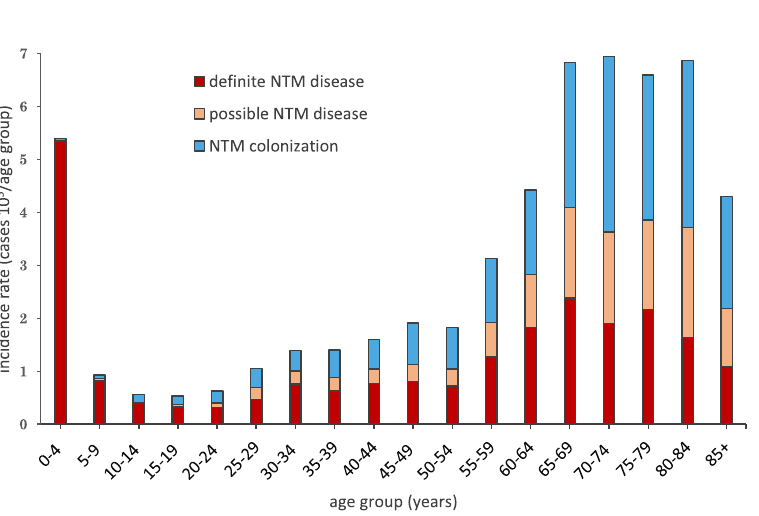
Figure 2. Incidence rates of NTM disease categories in the study period standardized to age groups.